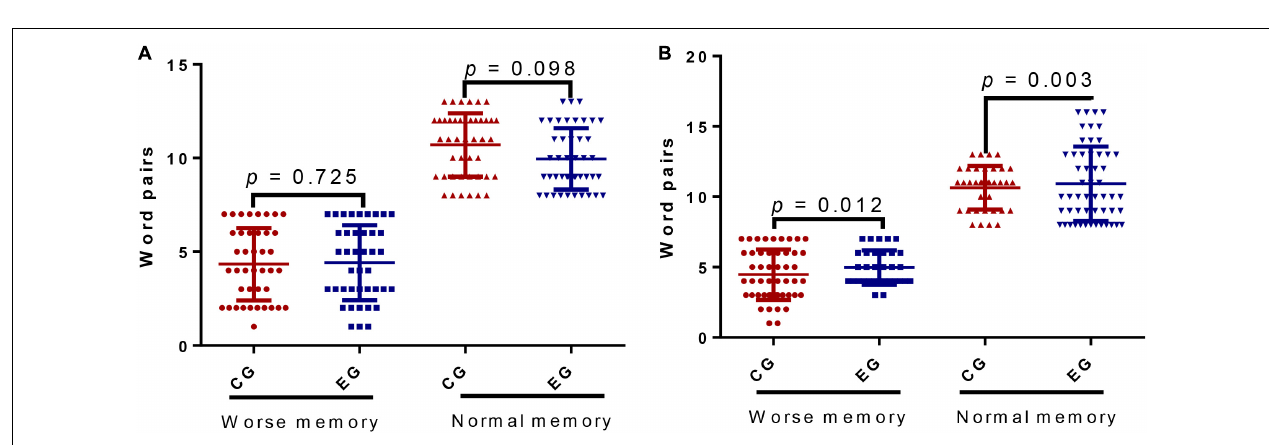
FIGURE 1 | Pittsburgh Sleep Quality Index (PSQI) scores between the control group (CG) and the eight-section brocades (ESB) exercise group (EG). (A) Before intervention in unadjusted analysis. (B) After 12-week intervention in unadjusted analysis. (C) Before intervention in adjusted analysis. (D) After 12-week intervention in adjusted analysis. Adjusted Cox proportional hazards models to assess the association between ESB and clinical outcomes by baseline PSQI, including age, gender, job, smoking and drinking habits and overweight (53). PSQI < 8 was regarded normal sleepers and PSQI ≥ 8 was designed as worse sleepers. n = 85 for each group and the statistical difference was significant if p < 0.05.